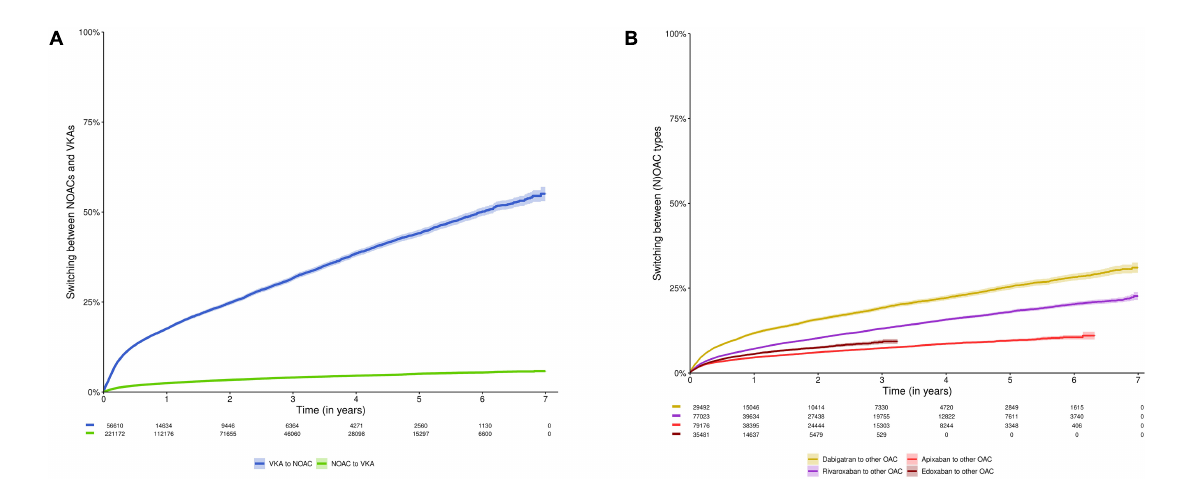
FIGURE4 Cumulative incidence curve of switching (A) NOACs to VKAs or vice versa; and (B) switching between any type of OAC (e.g., from dabigatran to rivaroxaban). Data shown as cumulative incidence with 95% confidence interval and risk table (number of patients at risk). In analysis (A) , subjects were censored in case of discontinuation of NOACs or VKAs (allowing switching between NOAC types and VKA types, respectively), death, emigration or end of the study period. In analysis (B) , subjects were censored in case of discontinuation of the index OAC type, death, emigration, or end of the study period. Due to their respective approval in September 2013 and October 2016, and the study period ending on December 31st, 2019, the maximum follow-up duration of apixaban and edoxaban users was limited to 6.3 years and 3.25 years, respectively. NOAC, non-vitamin K antagonist oral anticoagulant; OAC, oral anticoagulant; VKA, vitamin K